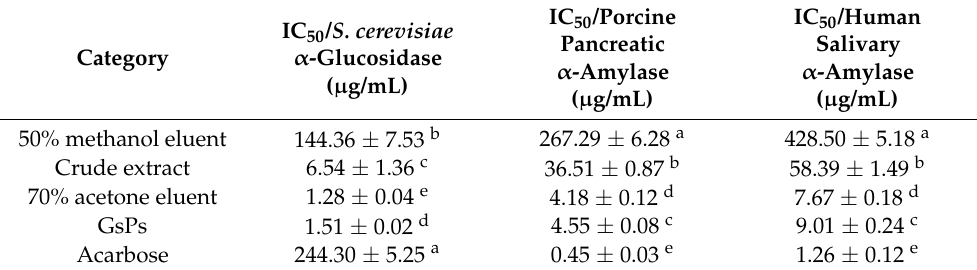
Table 7. The inhibitory activities of the 50% methanol eluent, crude extract and the 70% acetone eluent of rhizome of F. dibotrys , GsPs and acarbose against S. cerevisiae α -glucosidase, porcine pancreatic α -amylase and human salivary α